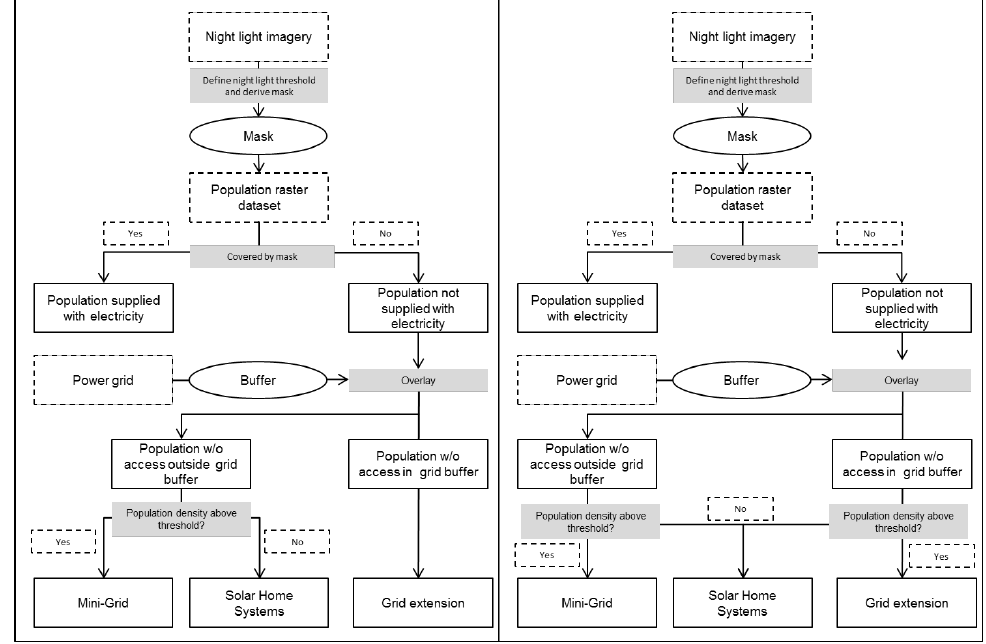
Figure 4. Flow chart of appropriate electrification option selection for excluding ( left ) and including ( right ) the population density within the grid